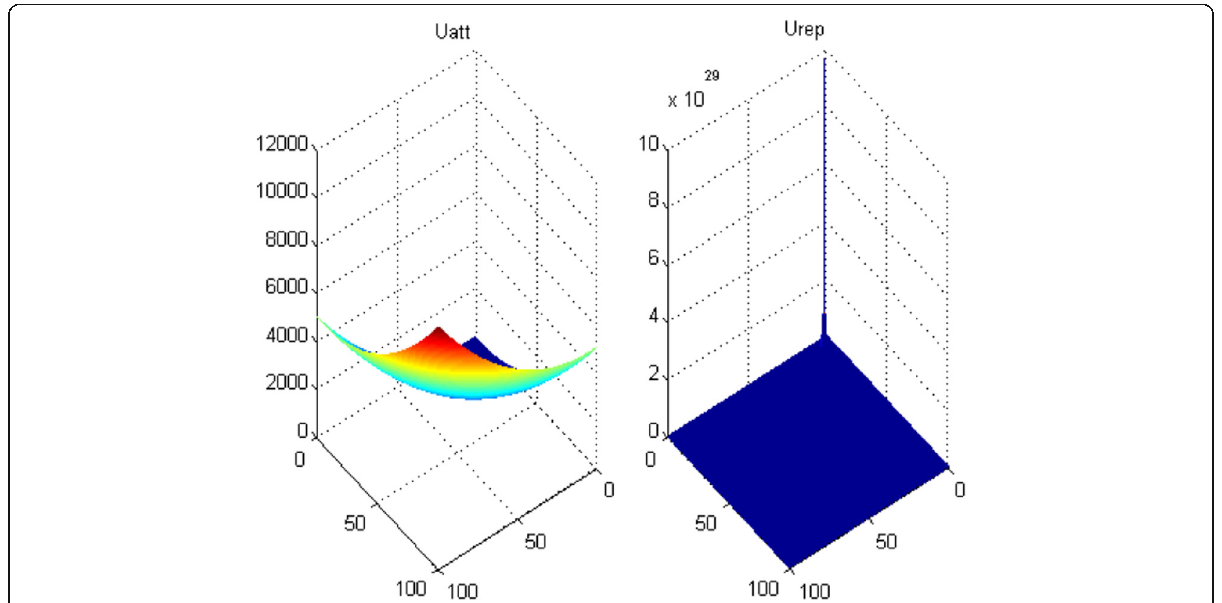
Fig. 28 Mesh plot of the potential energy of attraction and repulsion in the modified artificial potential field algorithm for the broken line